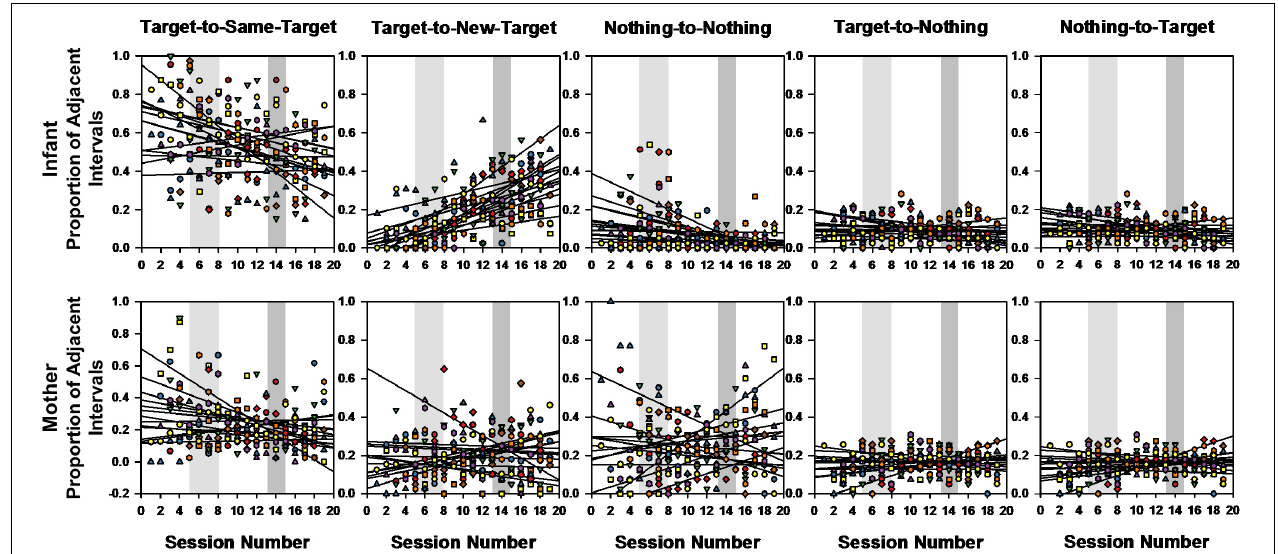
FIGURE 7 | Pearson correlations and corresponding regression lines showing the relation between the proportions that infants (top) and mothers (bottom) engaged in transitions from target-to-same-target, target-to-new-target, nothing-to-nothing, target-to-nothing, and nothing-to-target, by session number. Trend lines for each participant show the direction of the relation. Light gray and darker gray shaded areas span the range of session numbers during which different infants learned to crawl and walk, respectively.